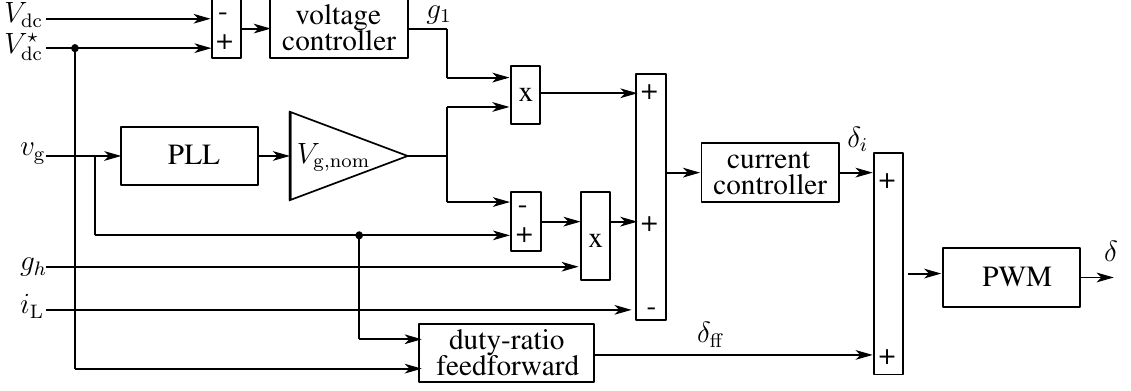
Figure 1. The Programmable Resistance Shunt Harmonic Impedance (PR-SHI) method for grid-connected distributed generation (DG)